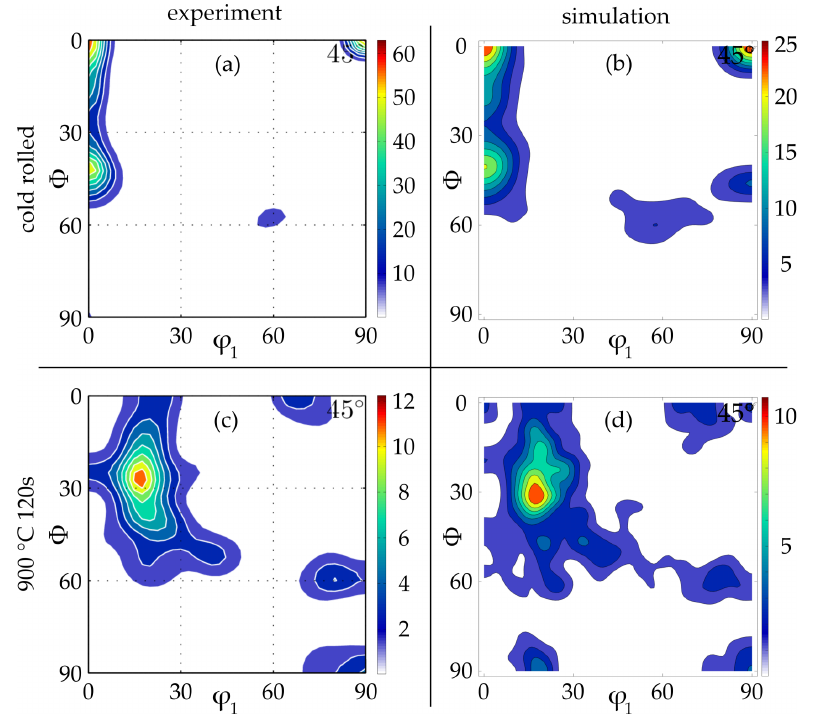
Figure 12. ODF ϕ 2 =45° section of the experimental ( a ) and simulation ( b ) cold rolling texture as well as the resulting experimental ( c ) and simulated ( d ) texture after annealing for 120s at